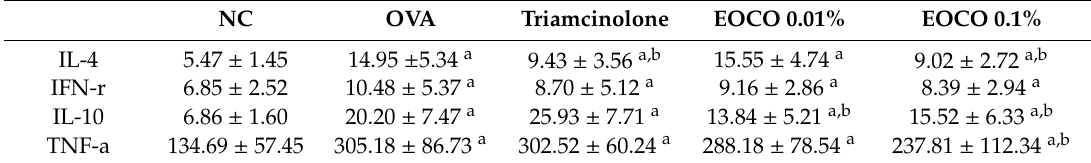
Table 2. E ff ects of essential oil from Chamaecyparis obtusa (EOCO) on the production of inflammatory mediators by splenocytes after stimulation with 100 µ g / mL of ovalbumin (OVA) (n = 8 mice per group).